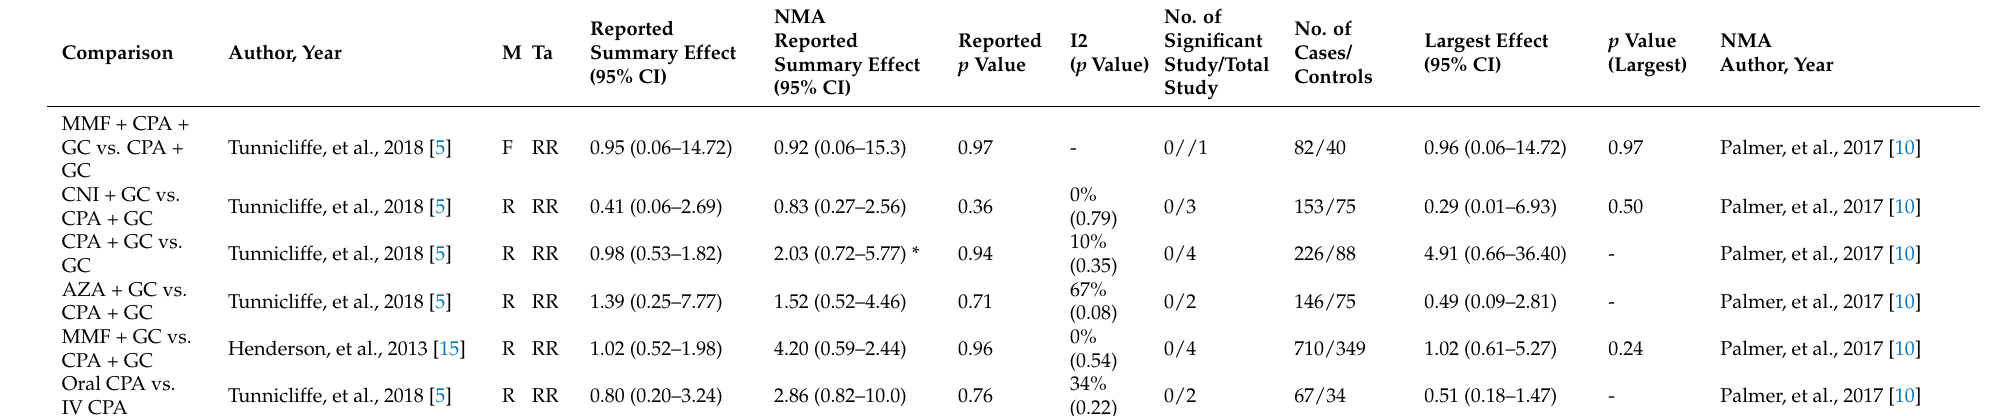
Table 6. Mortality during induction therapy (compared with Network